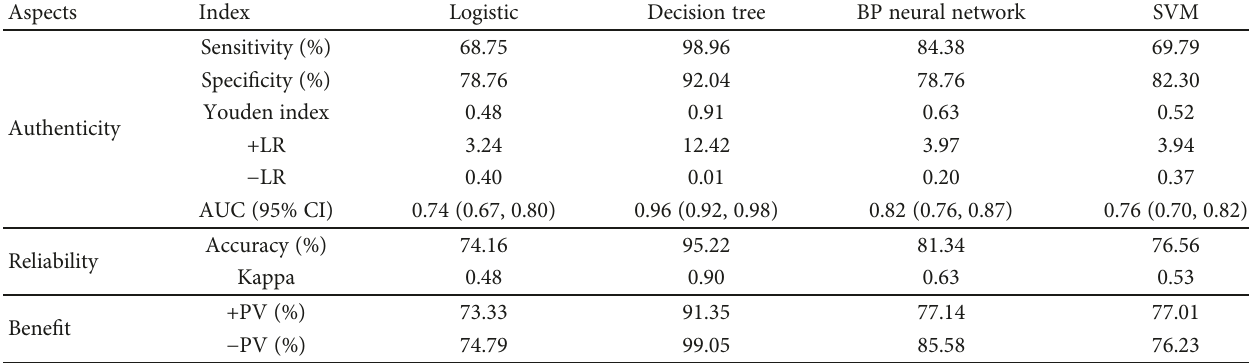
Table 6: The comparison of the training set evaluation index.